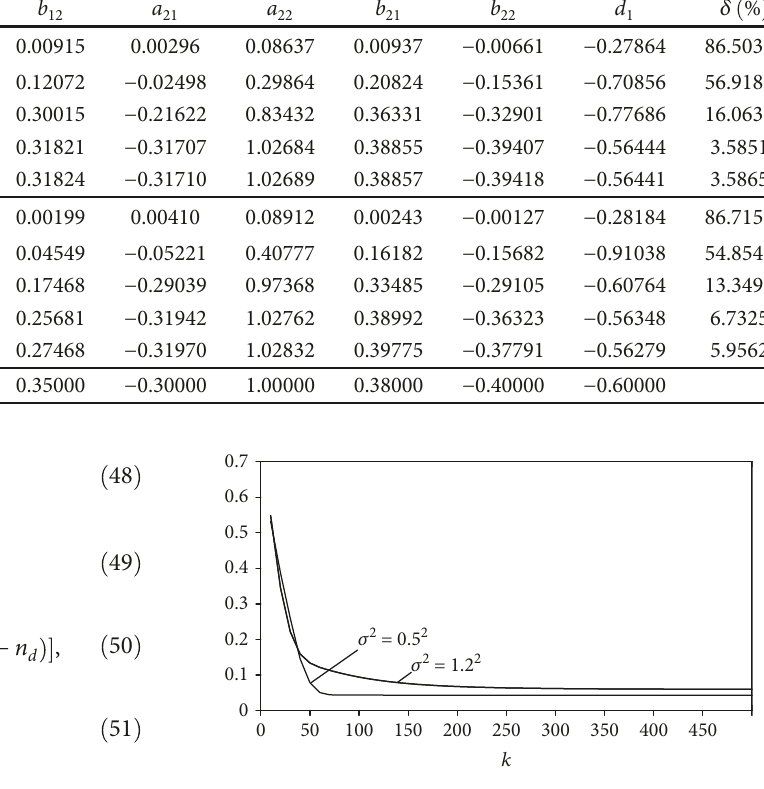
Figure 4: The CARMA-FGI estimation errors δ with di ff erent